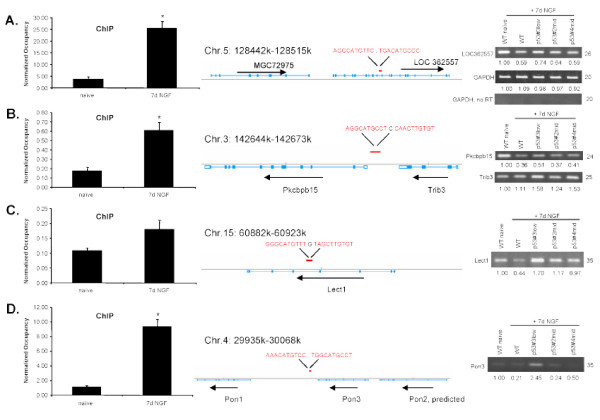
p53-repressed target genes. Panels A-D show site-specific qPCR ChIP results on left with standard deviation, where significance at p ≤ 0.05 is designated by an asterisk (*). Note the p53-occupied sequence in Panel B lies between genes which were both examined for changes in expression. Display and analyses are as described in Figure 4 legend.